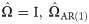
Noise ceiling estimates obtained in real fMRI data.Histograms represent the noise ceiling obtained for 50000 voxels of the temporal lobe for one subject. Every row in the figure presents the noise ceiling estimated under different parametrizations of the noise covariance matrix (from top to bottom: Ω^=I,Ω^AR(1) and Ω^NST). The left most columns show the analytical noise ceiling using the estimate of the covariance of the responses based on the different parametric models. The R2Rnc and the SHnc are presented in the two right most columns and, in each row, are computed based on the β^ obtained under different parametrizations of the noise covariance matrix.